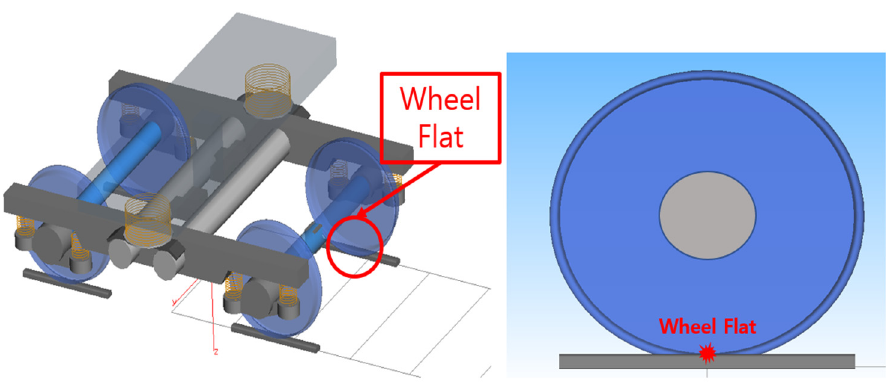
Figure 4. The location of the wheel flat.